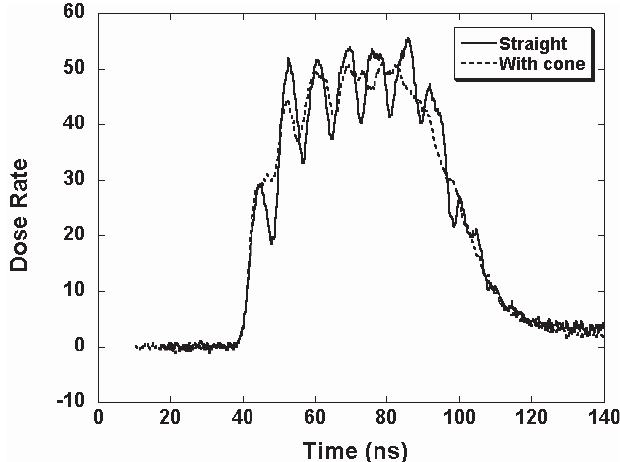
geometry.FIG. 16. Radiation dose rate measured with PIN diodes, with and without the conical field shaper of Fig.